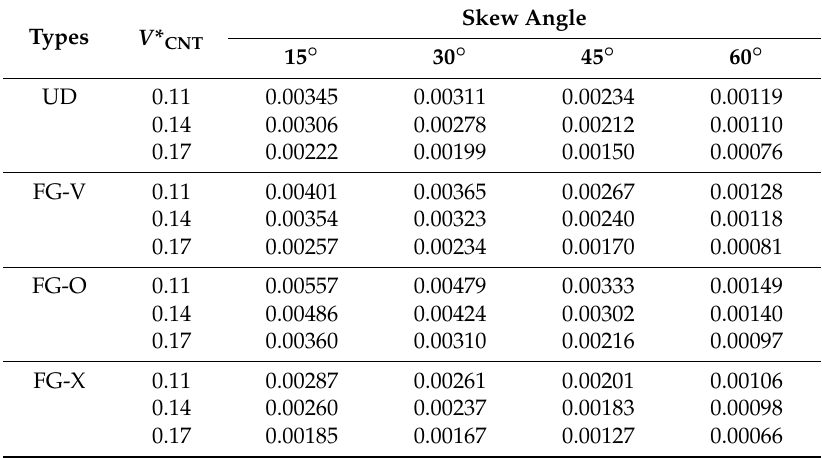
Table 14. Variation of non ‐ dimensional maximum deflection of FG ‐ CNT ‐ reinforced simply supported rhombic plate under uniform loading.